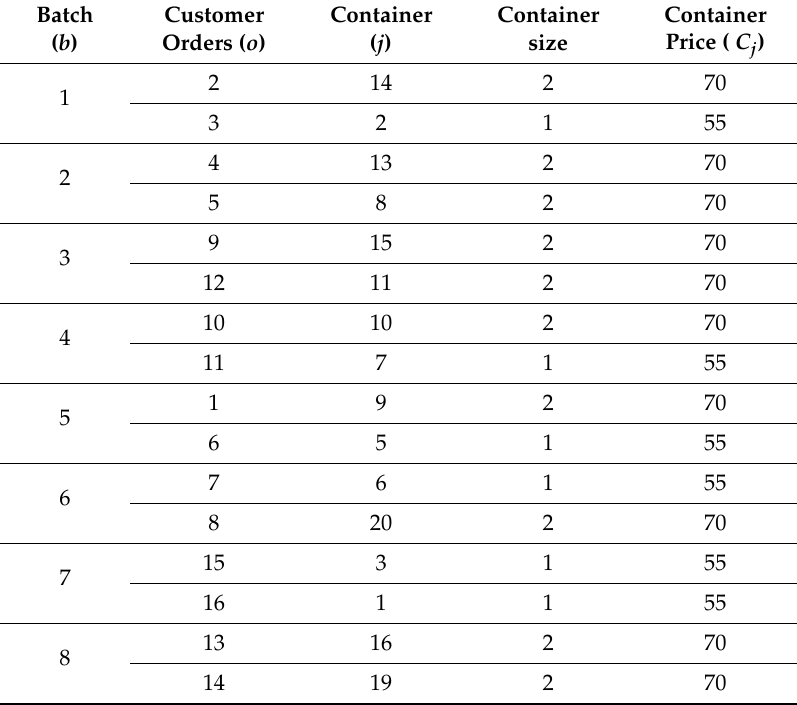
Figure 6. The schedule of batches. Table 10. The packaged container of customer